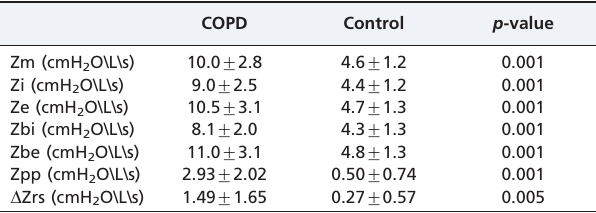
Table 3 - Area under the curve (AUC), sensitivity (Se), specificity (Sp) and cut-off point of the Forced Oscillation